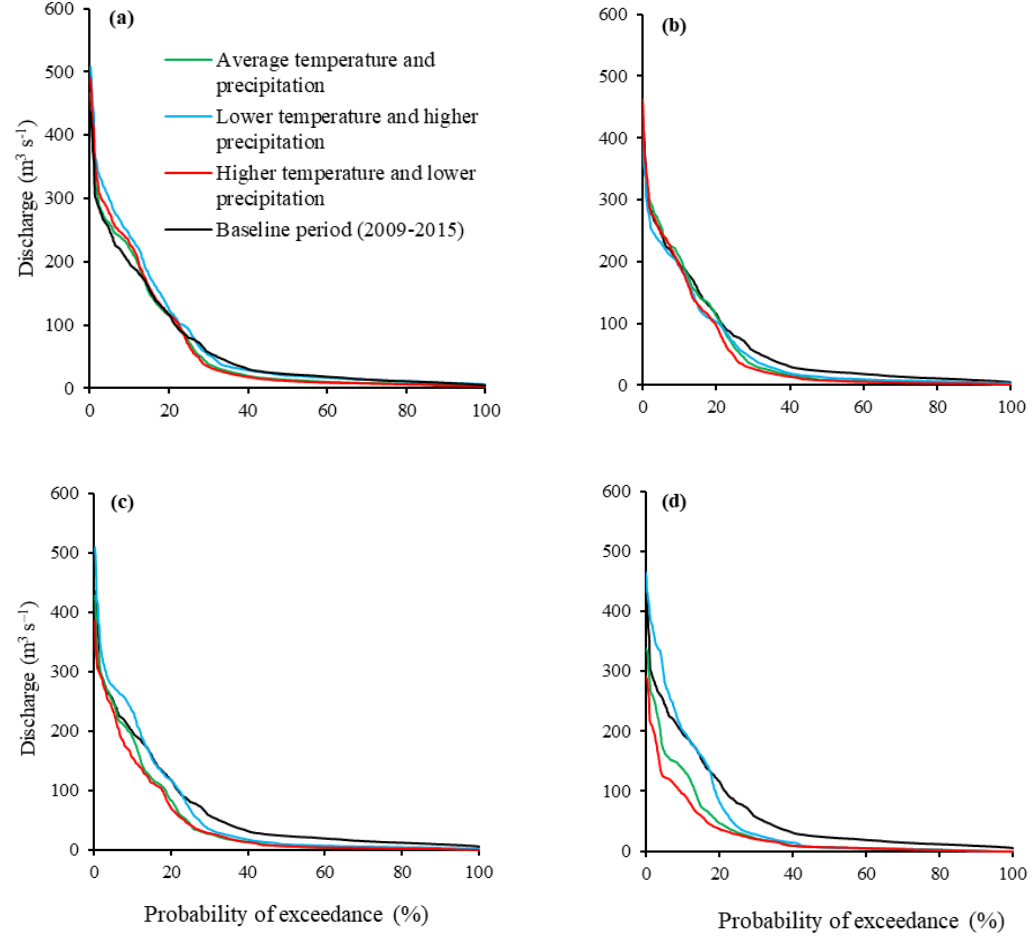
Figure 12. Streamflow exceedance probabilities in the future relative to the baseline period in the Panjshir sub-basin under three climate change scenarios during the mid-21st century (2049–2055) under ( a ) RCP 4.5 and ( b ) RCP 8.5, and during the late-21st century (2089–2095) under ( c ) RCP 4.5 and ( d ) RCP 8.5.